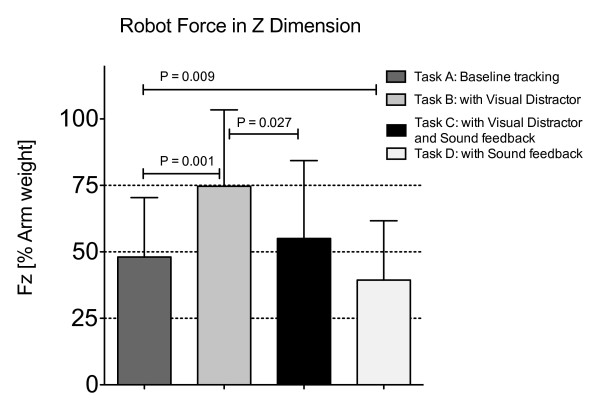
Robot force in Z dimension. Robot assistance force in the z (vertical) direction for participants with stroke using their paretic arms to track, relative to assistance force when the participants completely relaxed their arms in Task E.